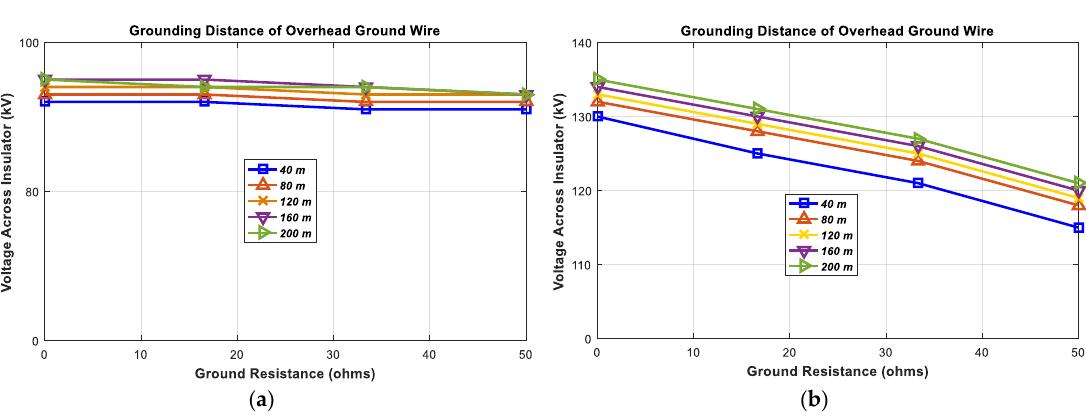
Figure 15. Voltage across the insulator in case of a lightning strike to the overhead ground wire (lightning current wave shape = 4.12/77.5 μs, lightning current = 40 kA); ( a ) Strike to the middle of the overhead ground wire; ( b ) Strike to the end of the phase conductor.